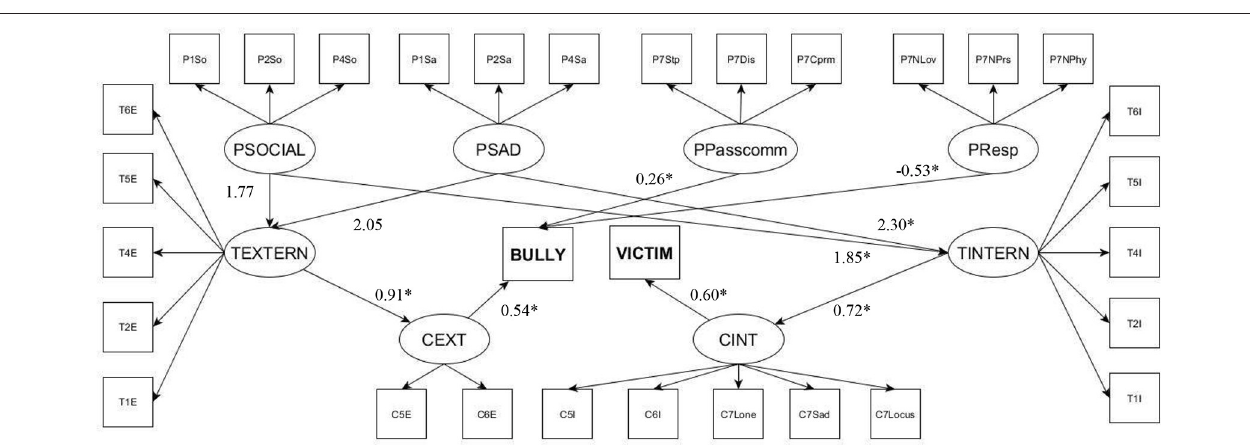
FIGURE 2 | Final structural equation model. Error variances are not